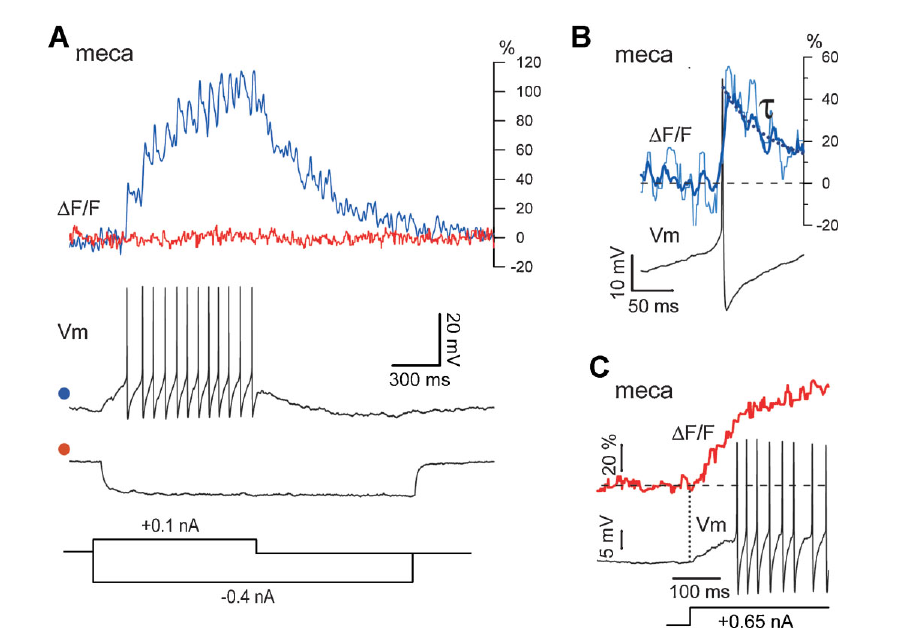
Figure5. PN glomerular fluorescence after blockade of nicotinic synaptic input with mecamylamine . Odor delivery failed to depolarize the PN and baseline activity was close to 0sp/second. ( A ) Current-evoked spike trains lead to clear summation of F transients, but current-evoked hyperpolarization leads to no further decrease in F, indicating that baseline PN fluorescence in intact animals is elevated because of tonic synaptic depolarization. ( B ) Spike-evoked calcium transients (single event: thin line; spike-triggered average (STA) of seven events: thick line) with decay time constant ( τ = 50 ± 7ms). ( C ) Upon large current injection, causing fast PN depolarization, F increases prior to the first action potential, indicating low-voltage-gated calcium entry, consistent with high baseline fluorescence in intact